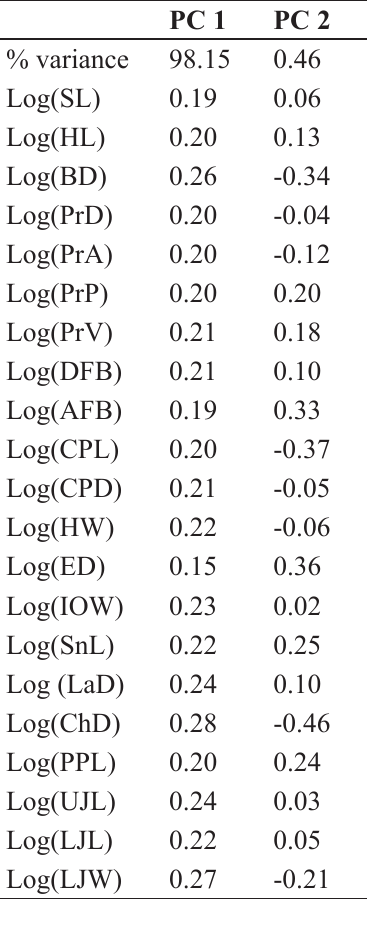
Table S6. PCA loadings of 21 log-transformed measurements from: H . pardus sp. nov. and H . quasimodo sp. nov.. Results illustrated in Fig. 3f. Abbreviations: SL = standard length; HL = head length; BD = body depth; PrD = predorsal distance; PrA = preanal distance; PrP = prepectoral distance; PrV = prepelvic distance; DFB = dorsal fin base length; AFB = anal fin base length; CPL = caudal peduncle length; CPD = caudal peduncle depth; HW = head width; ED = eye diameter; IOW = interorbital width; SnL = snout length; LaD = lachrymal depth; ChD = cheek depth; PPL = premaxillary pedicel length; UJL =